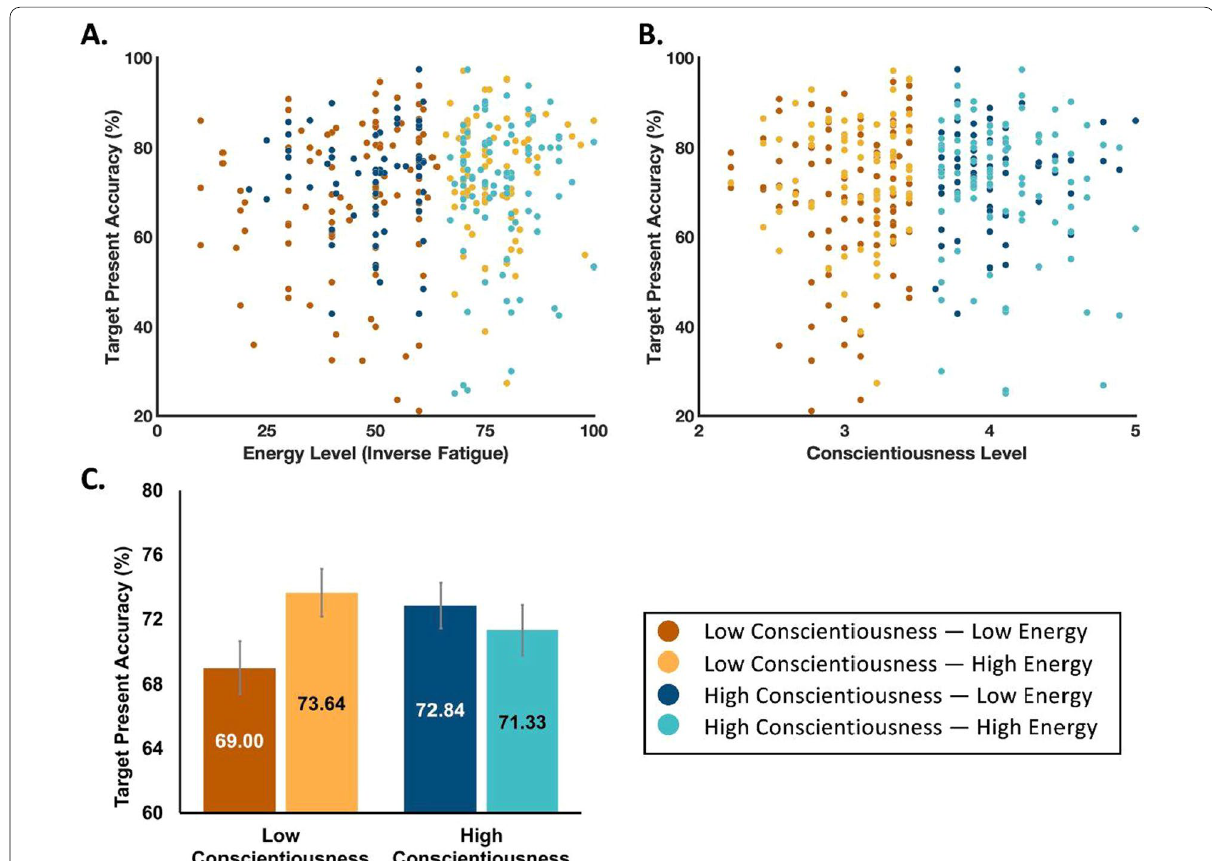
Fig. 2. Target-present accuracy by energy and conscientiousness to provide an illustration of the LME model of accuracy. All data are grouped relative to median energy level and median conscientiousness as indicated in the legend in the lower right. A Accuracy by energy. B Accuracy by conscientiousness level. C Data divided into four groups to illustrate the primary linear mixed-effect model analysis on accuracy. Error bars